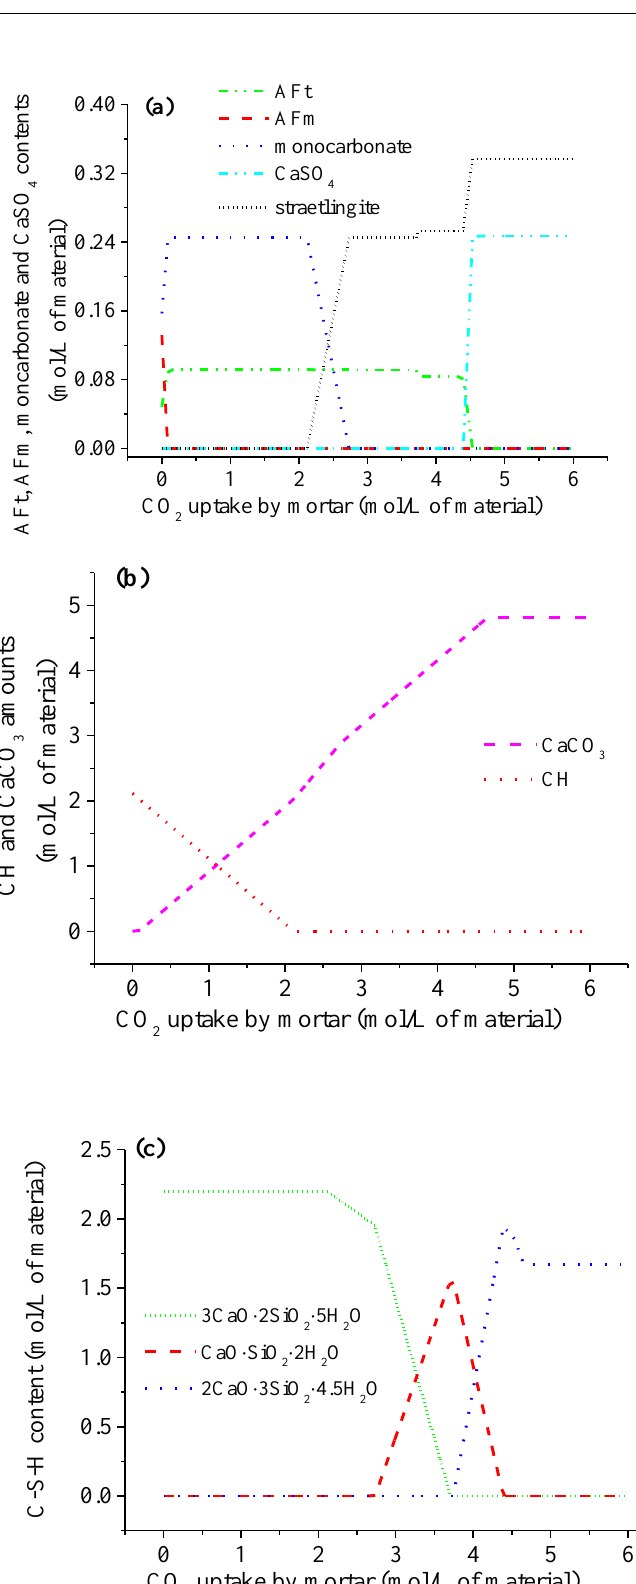
Figure 5. Phase assemblages of the hardened cement paste in the air-carbonated mortar as a function of the CO 2 uptake: ( a ) AFm, AFt, moncarbonate and CaSO 4 ; ( b ) CH and CaCO 3 ; ( c ) C-S-H.